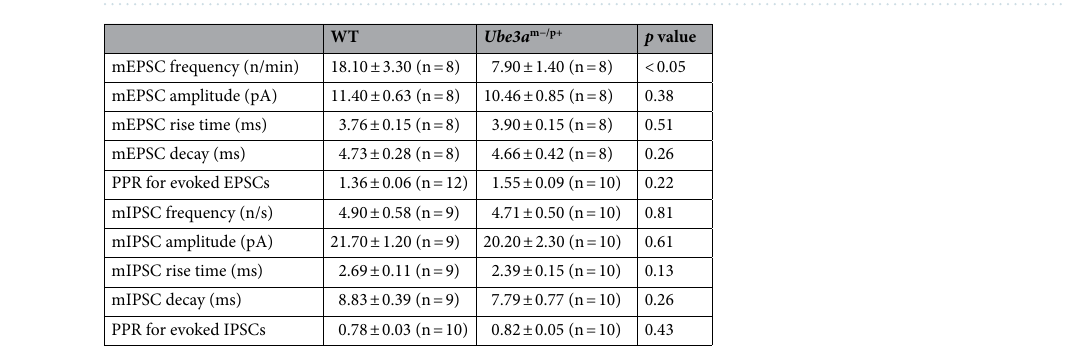
Table 1. Properties of excitatory and inhibitory synapse transmission onto CA1 pyramidal neurons. mEPSC miniature excitatory postsynaptic current, mIPSC miniature inhibitory postsynaptic current, PPR paired-pulse ratio, WT